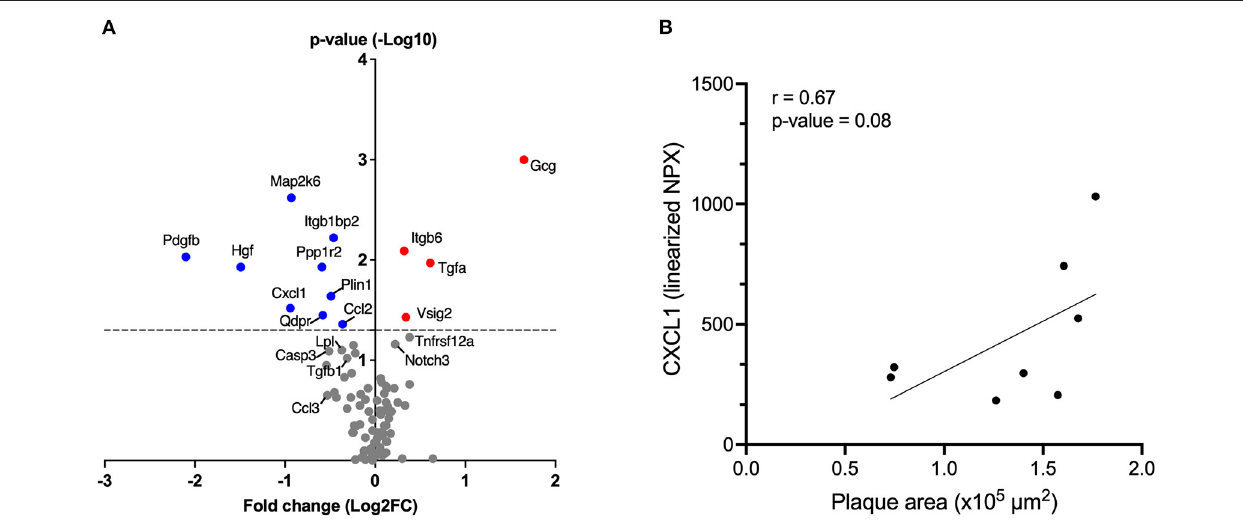
FIGURE 3 | Affibody molecule against IL17A reduces plasma levels of inflammatory and/or atherosclerosis-associated proteins in ApoE − / − mice. The Volcano plot shows fold changes (FC) and p -values of differentially altered plasma proteins analyzed by olink proteomics, in mice treated with α IL17A Affibody molecule ( n = 11) compared to sham ( n = 12) (A) . The p -values are presented on log10 scale while the FCs were calculated from linearized normalized protein expression (NPX) values and presented on log2 scale. Positive log2 fold change values correspond to higher protein levels and negative values correspond to reduced protein levels in mice treated with α IL17A Affibody molecule. The horizontal dotted line reflects the cut-off for statistical significance ( p < 0.05). Blue circles highlight proteins with a significant decrease ( p < 0.05) and red circles highlight proteins with a significant increase ( p < 0.05). Gray circles represent proteins with no statistical significance. Correlation between the plasma concentration of CXCL1 protein and the area of aortic root lesion in atherosclerotic prone ApoE − / − mice ( n = 8) (B) .